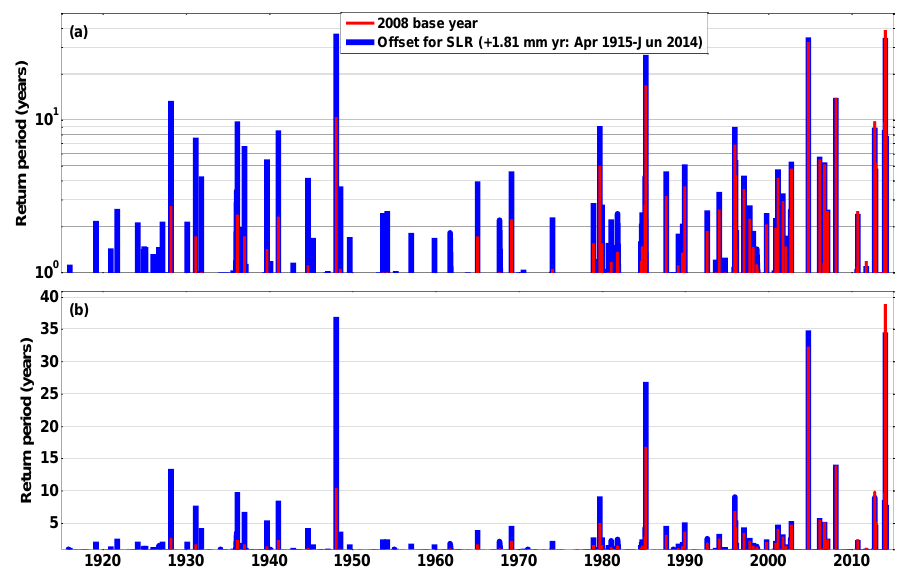
Figure 3. (a) Return periods at Newlyn for high water events of ≥ 1 in 1 year, for both the fixed 2008 baseline and offset for SLR across the data record; (b) plotted with a non-logarithmic y axis scale. Table 2. The largest sea level events at Newlyn: top 20 (ranked by sea level). Sea